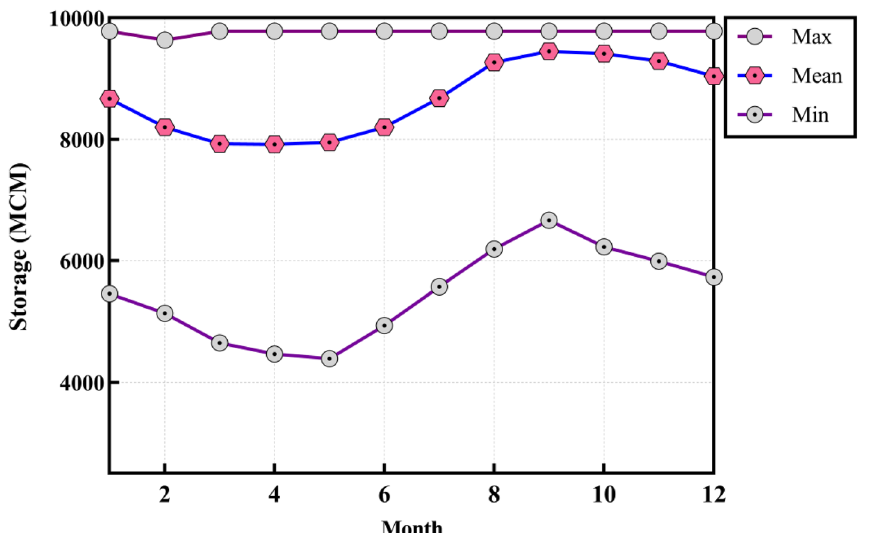
Figure 15. Monthly maximum, minimum, and average of reservoir storage gained by